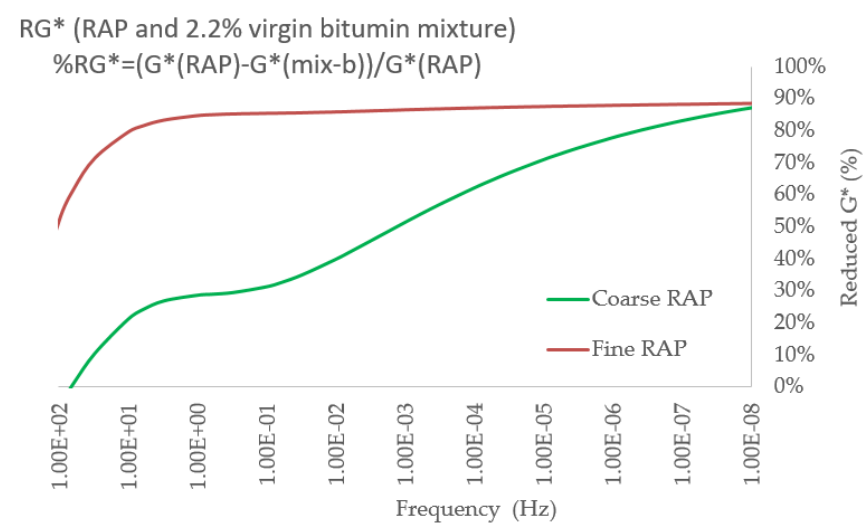
Figure 7. Reduced G* for CR and FR at 10 °C.